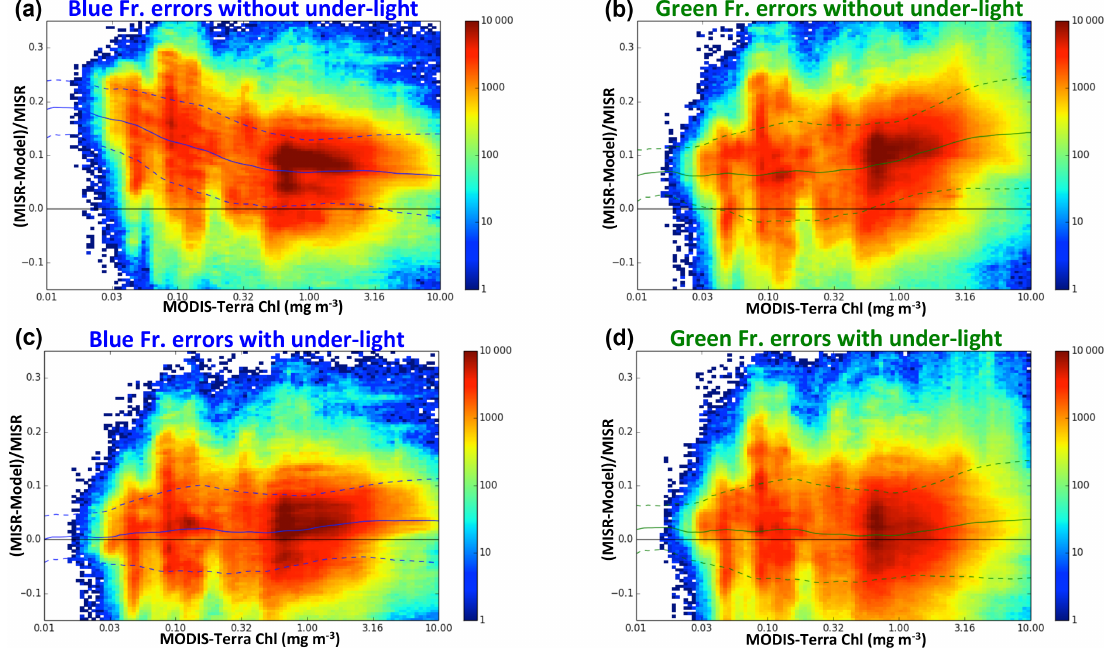
Figure 2. The effect of including under-light, assessed by comparing the MISR-observed TOA reflectances with model-simulated values, not including (a, b) and including (c, d) under-light calculated with independently retrieved MODIS Chl values. These joint histograms show (MISR-Model)/MISR TOA reflectance for the blue (446nm, a, c ) and green (558nm, b, d ) spectral bands, as a function of MODIS Chl. All glint-free cameras are aggregated for this analysis. The solid blue (or green) lines represent the smoothed mean bias, and the dashed lines indicate ± 1 smoothed standard deviation. AOD and mixture were obtained by running the RA with under-light included, based on the MODIS Chl, and finding the best-fitting mixture and AOD (using only the NIR band, but up to 9 cameras). Once AOD and mixture were obtained, the TOA reflectances were calculated with the forward model, both with and without under-light. Results show that including under-light dramatically lowers the bias in both the blue and green bands for all Chl up to 10mgm − 3 . As expected, because chlorophyll a strongly absorbs in the spectral response range of the MISR blue wavelength, the contribution of under-light to the TOA reflectance decreases with Chl in the blue, whereas it increases with Chl in the green due to the enhanced scattering from